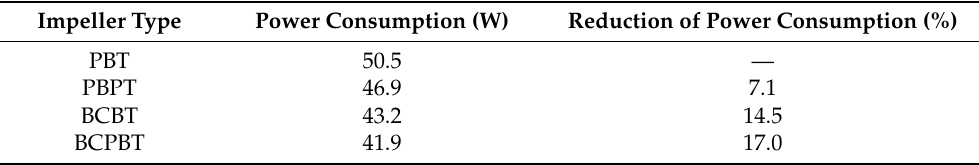
Table 4. Effect of impeller type on power consumption.